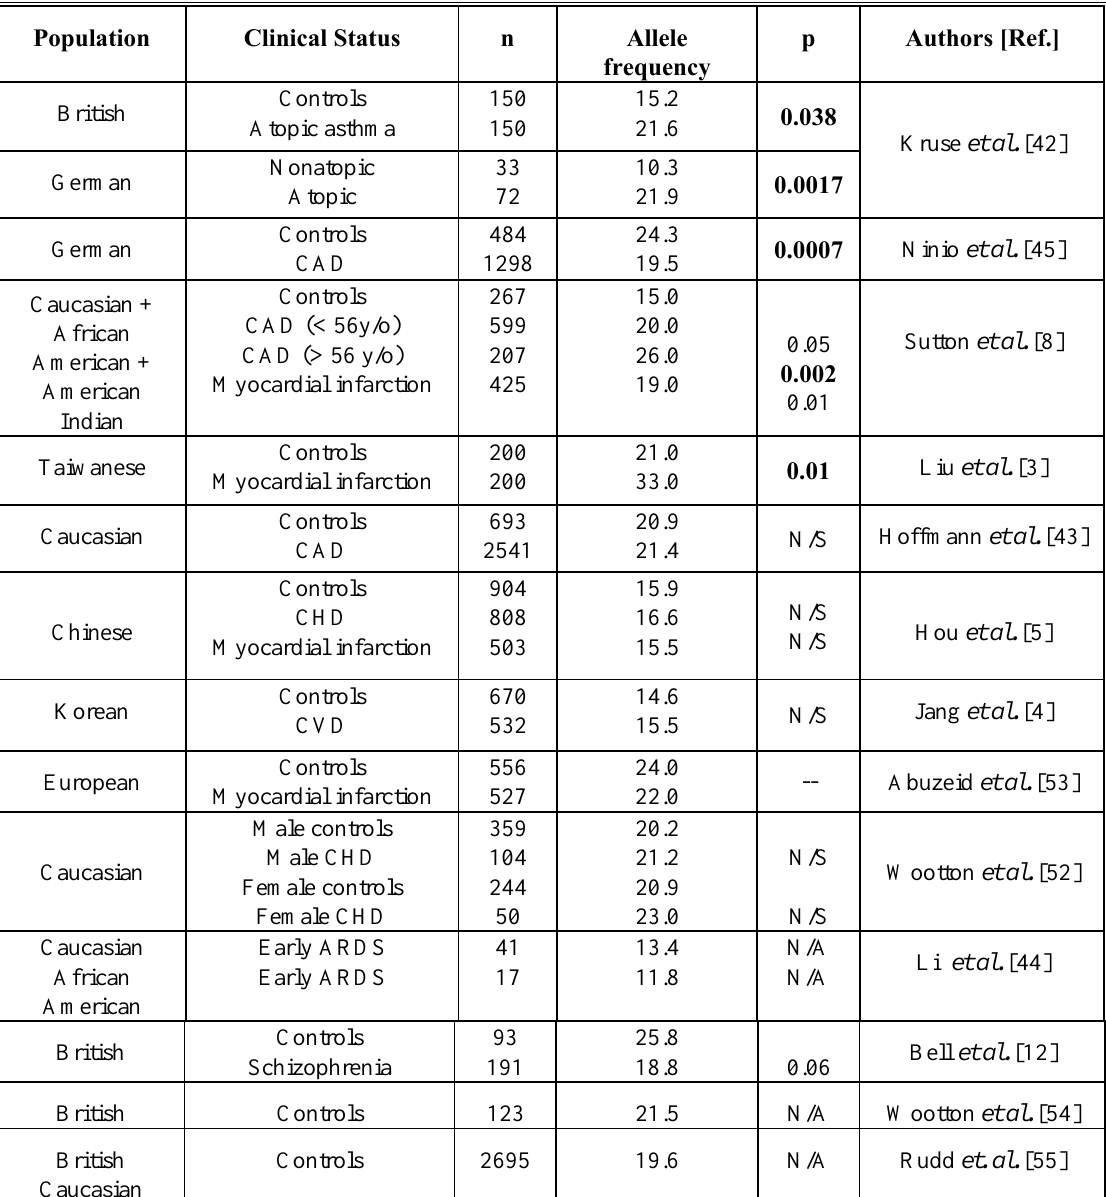
Table 5. The A379V (rs1051931) polymorphism: allele frequency in control and diseased populations. Population Clinical Status n Allele